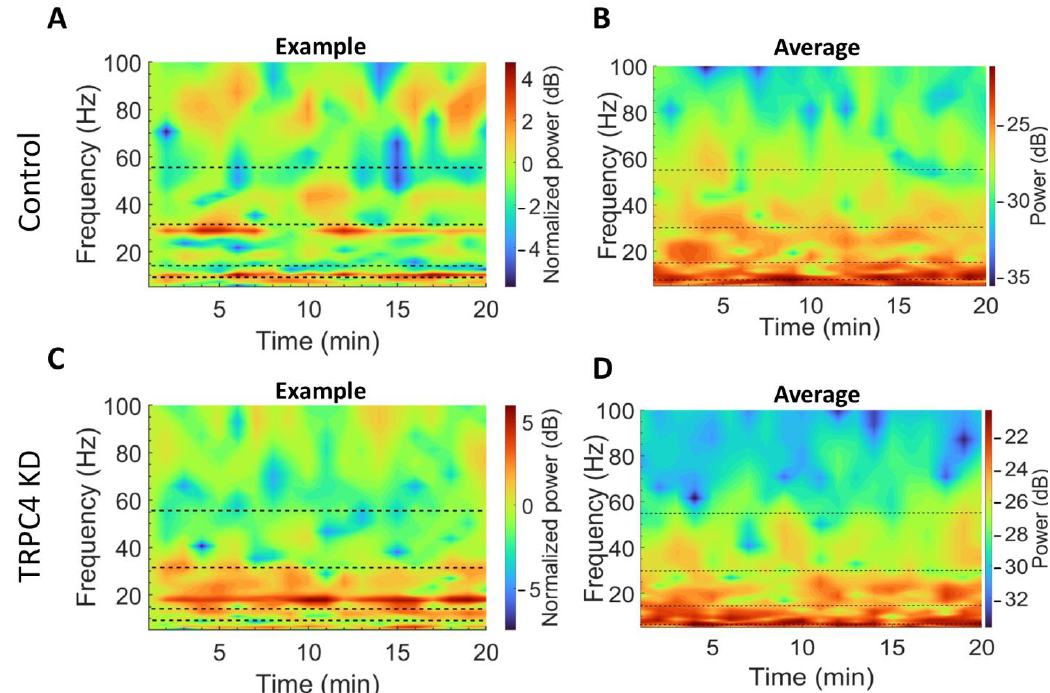
Figure 3. Time-frequency analysis of LFP. ( A , B ) Example and average spectrograms, respectively, from the scramble control group. ( C , D ) Example and average spectrograms, respectively, from the TRPC4 KD group. Spectrograms of individual examples ( A , C ) are normalized to the power at the first minute.